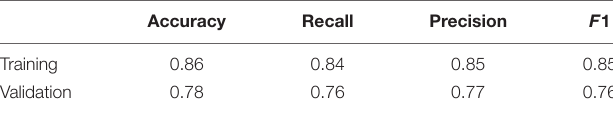
TABLE 1 | Test results on the training and validation